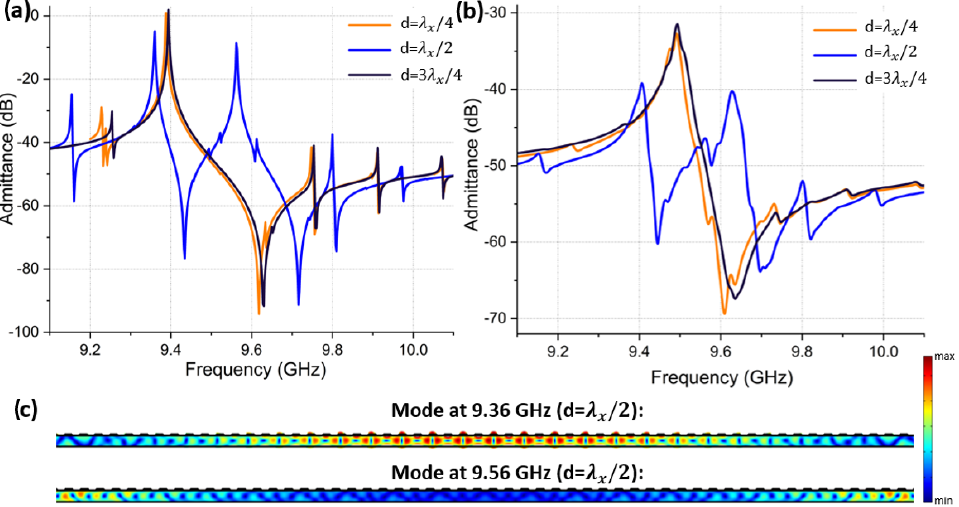
Figure 11. ( a )Simulated admittance response of CLMR with d set to λ x /4, λ x /2 and 3 λ x /4. ( b ) Mea- sured admittance response of CLMR with d set to λ x /4, λ x /2 and 3 λ x /4. ( c ) Mode shape of the two modes that appeared in the admittance response when λ x